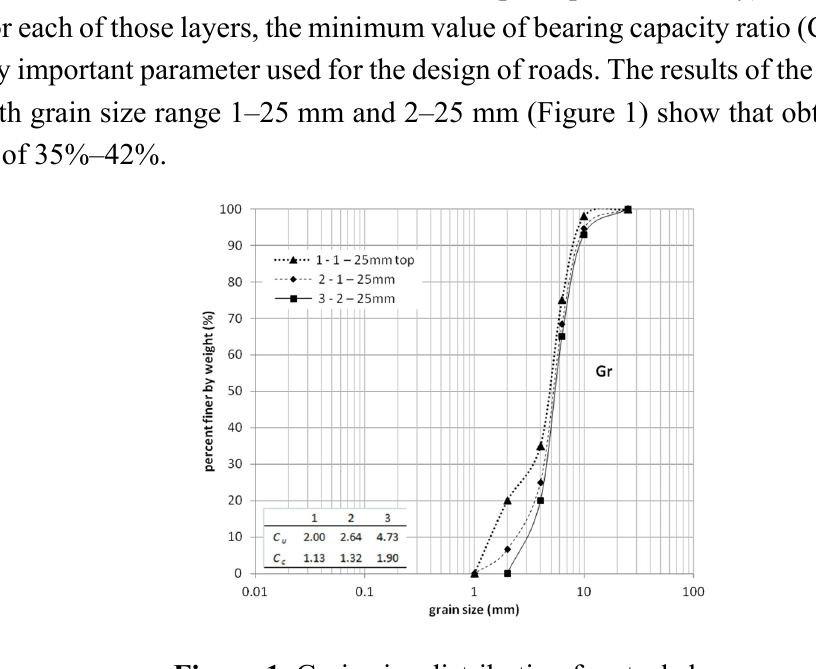
Figure 1. Grain size distribution for steel